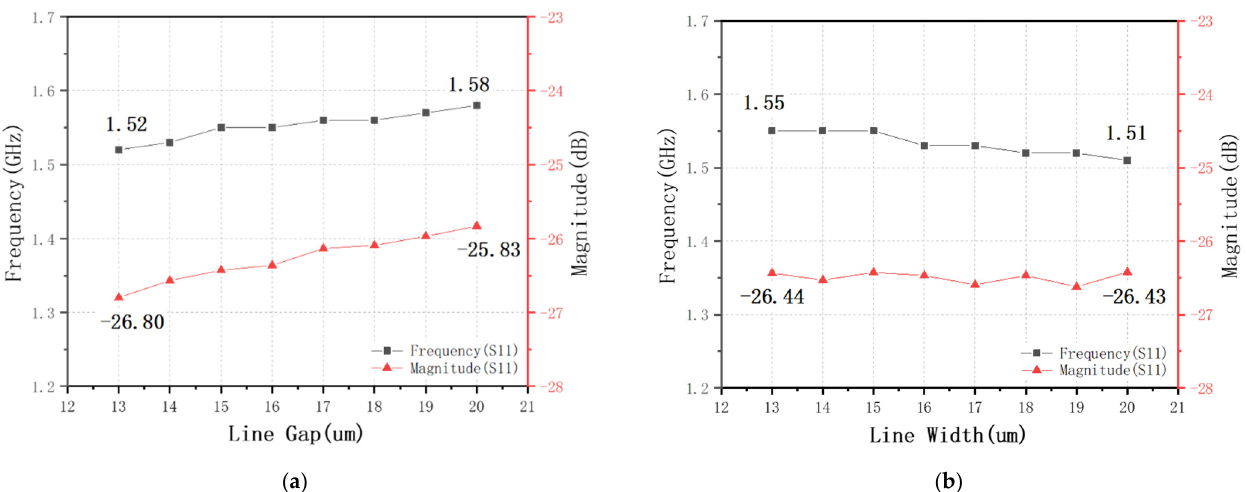
Figure 3. Shifting liner analysis of the center frequency and magnitude with different layout pa- rameters: ( a ) line gap and ( b ) line width.